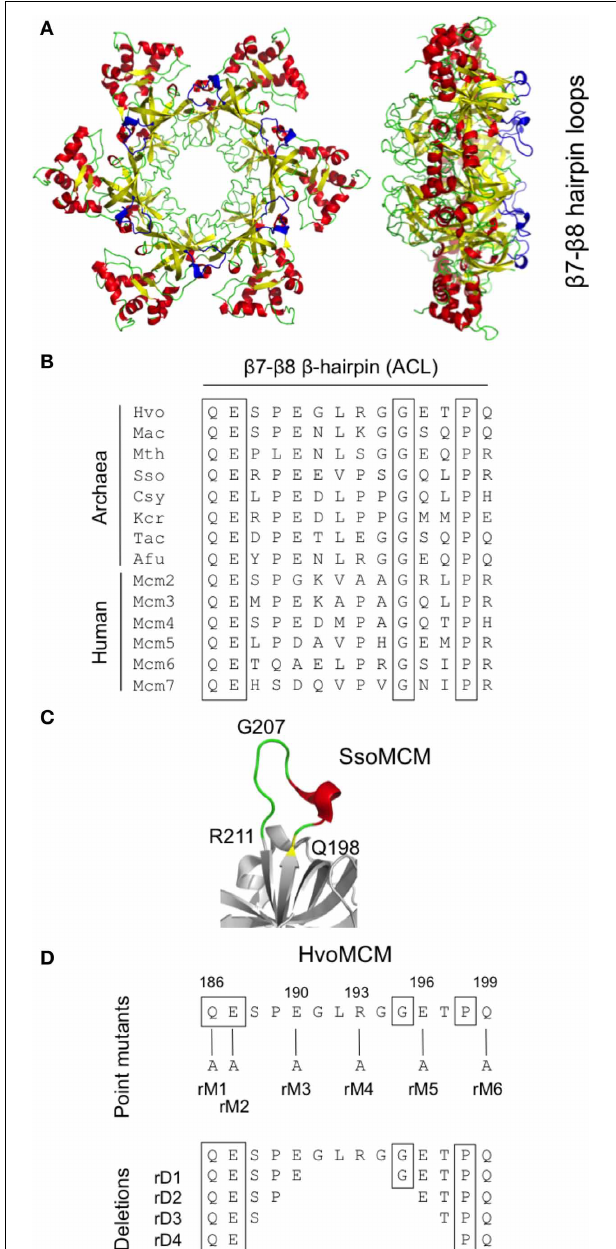
FIGURE 3 | Mutagenesis of the β 7- β 8 β -hairpin loop. (A) Two views of the three-dimensional structure of the S. solfataricus MCM N-terminal domain hexamer (PDB entry 2VL6) with the β 7- β 8 β -hairpin loop colored in blue. (B) Alignment of β 7- β 8 β -hairpin loop region from MCM proteins from diverse archaeal species (Hvo, Haloferax volcanii ; Mac, Methanosarcina acetivorans ; Mth, Methanothermobacter thermoautotrophicus ; Sso, Sulfolobus solfataricus ; Csy, Cenarchaeum symbiosum ; Kcr, Korarchaeum cryptophilum ; Tac, Thermoplasma acidophilum ; Afu, Archaeoglobus fulgidus ) and from human. Conserved amino acids are boxed. Detailed strain designations and protein accession numbers can be found in Table 1 . ( C) Close-up view of β 7- β 8 β -hairpin loop in S. solfataricus MCM (PDB 2VL6). (D) Location and nature of intended mutations in Hfx. volcanii MCM protein. Attempts were made to construct six single amino acid substitutions (rM1–6) and four deletions (rD1–4). See text for details.